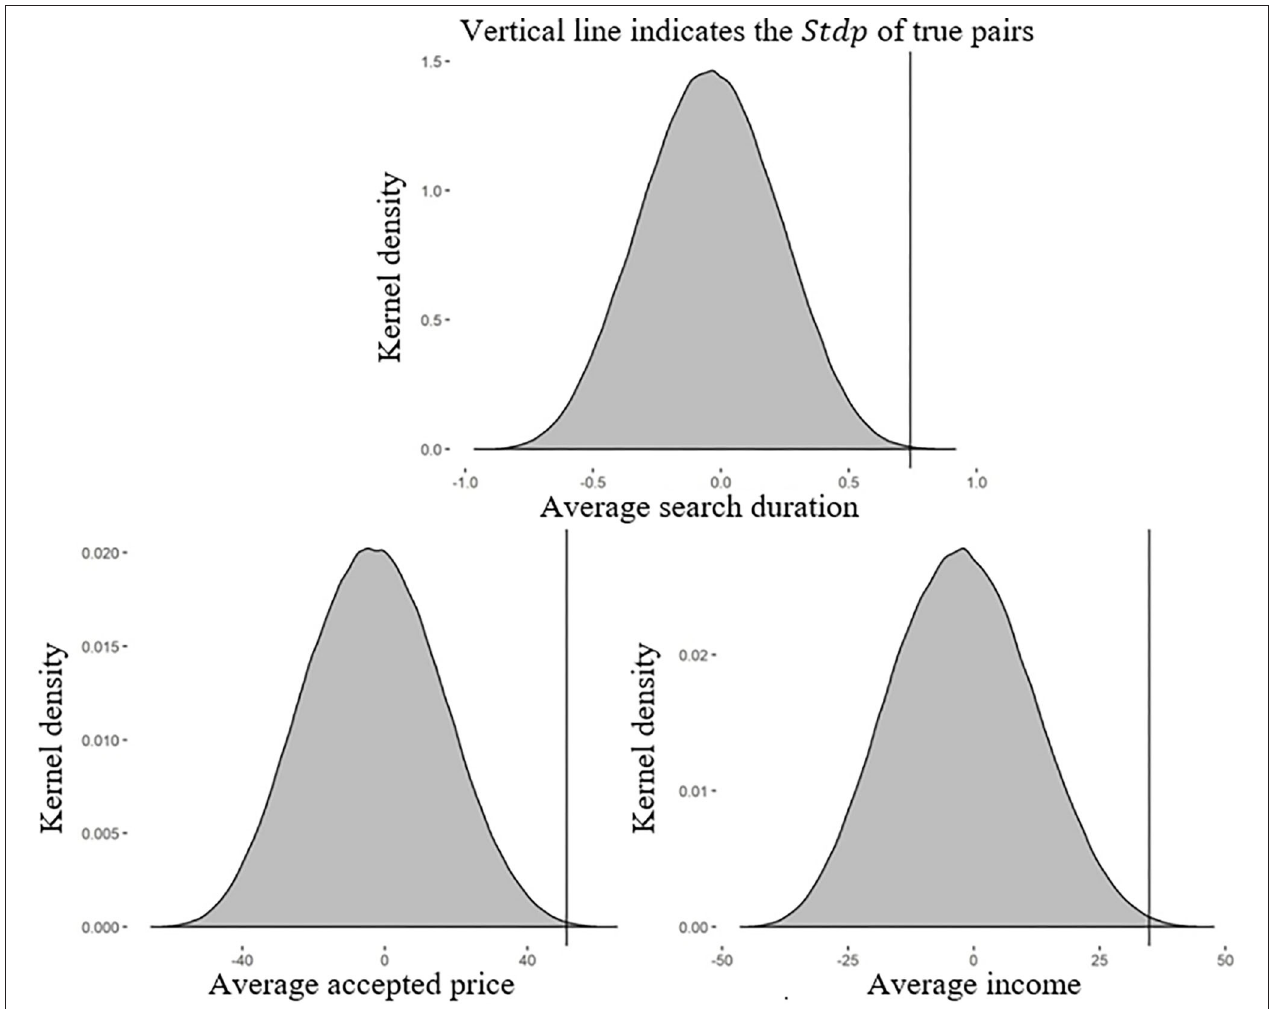
FIGURE 2 | Kernel density of the Stdp of the true pairs in the pair treatment and the simulated pairs in the single treatment. In the absence of peer effects, the differences between the Stdp s of the pair and single treatments should not be systematically positive or negative. By contrast, Stdp values for the pair treatment (the vertical lines) higher than 99.5% of those generated by the simulated pairs in the single treatment (the distributions) in our experiment indicate significant peer effects in the pair